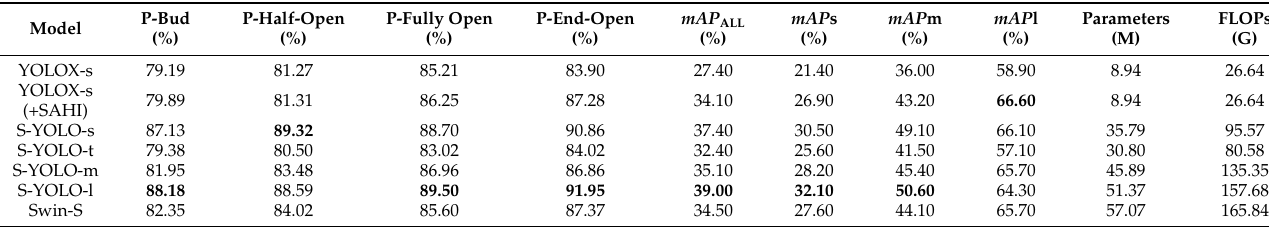
Table 7. Results of ablation